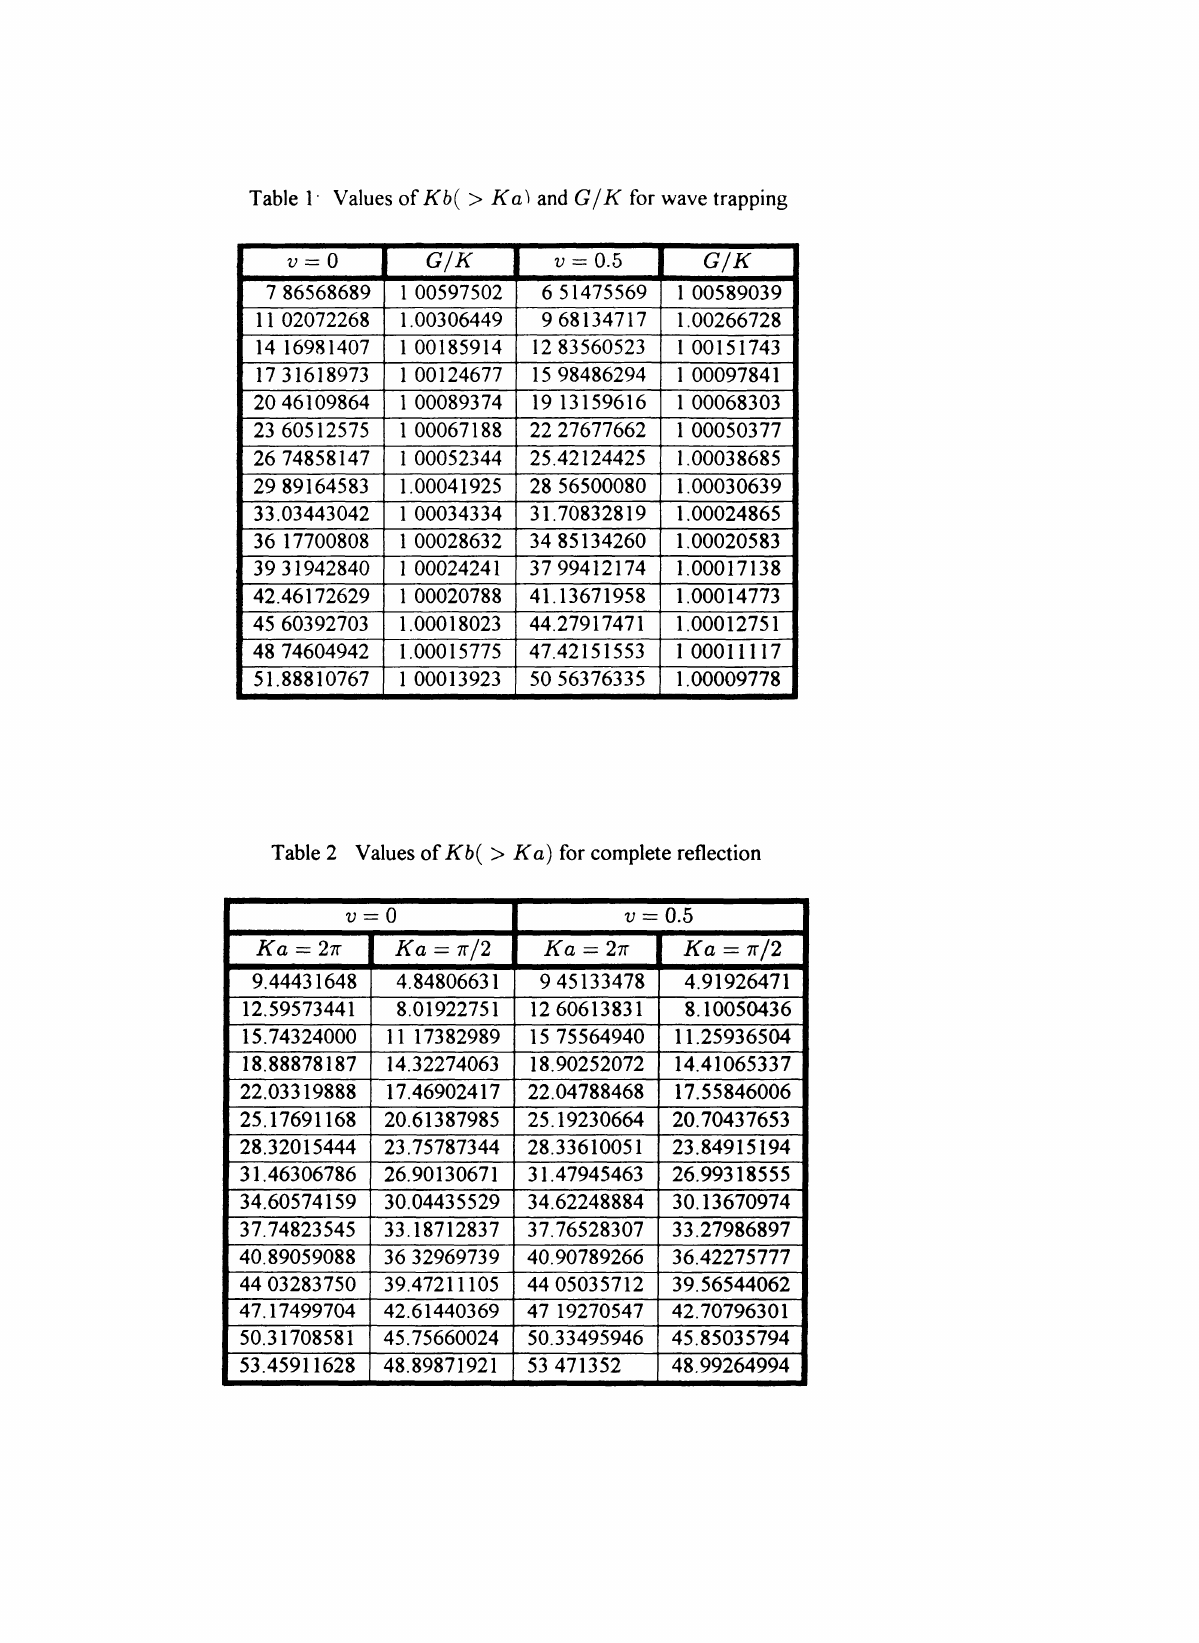
Table 2 Values of Kb( > Ka) for complete